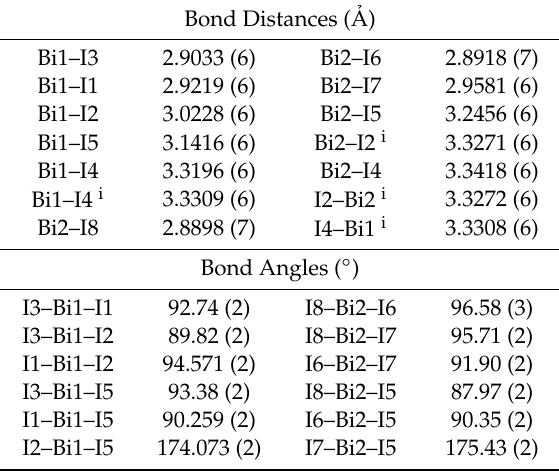
Table 2. Selected bond distances and angles of Bi 4 I 16 · 4(C 6 H 9 N 2 ) · 2(H 2